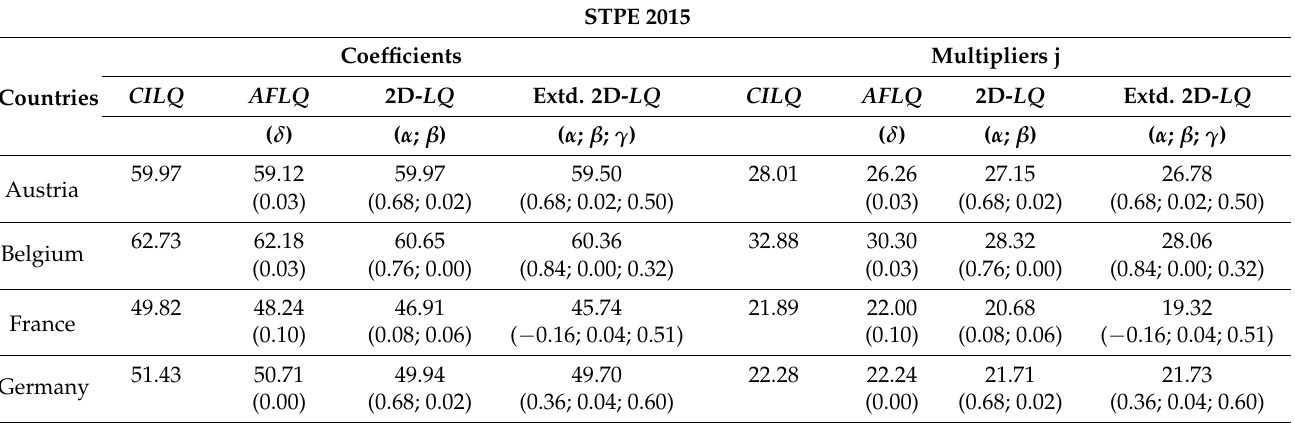
Table A3. LQ s: coefficients and multipliers